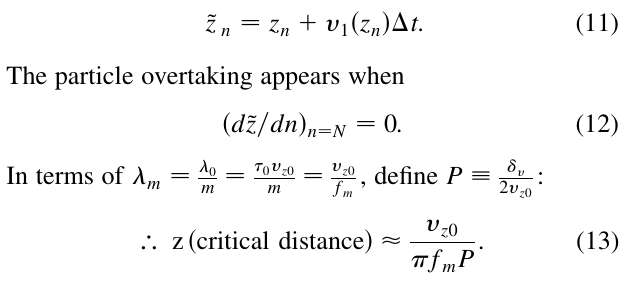
FIG. 7. An example of particle overtaking in v space in the beam frame.